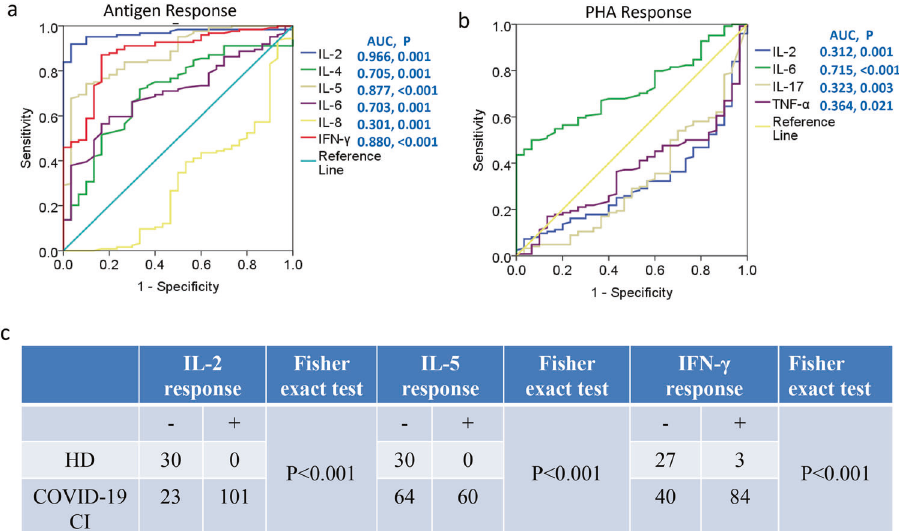
Fig. 5 SARS-CoV-2 antigen-activated cytokine responses distinguished COVID-19 convalescent individuals from healthy donors. Receiver operator characteristic curves for cytokines activated by the antigen ( a ), and activated by PHA ( b ), comparison of data for COVID-19 convalescent individuals and healthy donors. c SARS-CoV-2 antigen-activated IL-2, IL-5, and IFN- γ were associated with COVID-19 convalescent individuals. ROC, Receiver operating characteristic, AUC, area under curve, HD, healthy donor, CI, convalescent